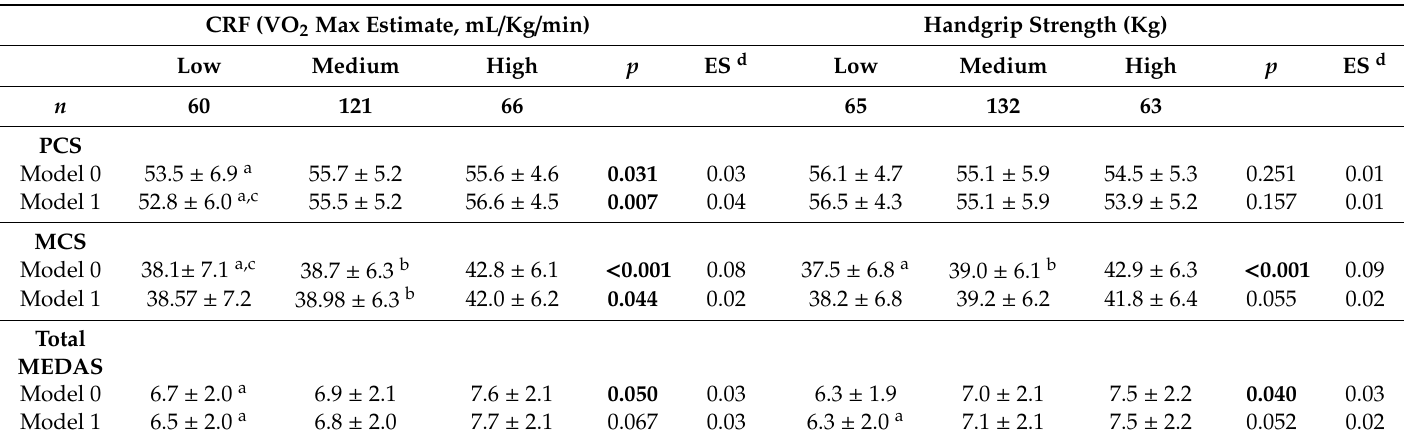
Table 3. ANCOVA models comparing the means of physical HRQoL (PCS), mental HRQoL (MCS), and total Mediterranean Diet Adherence Screener (MEDAS-14) score according to categories of cardiorespiratory fitness (CRF) and handgrip